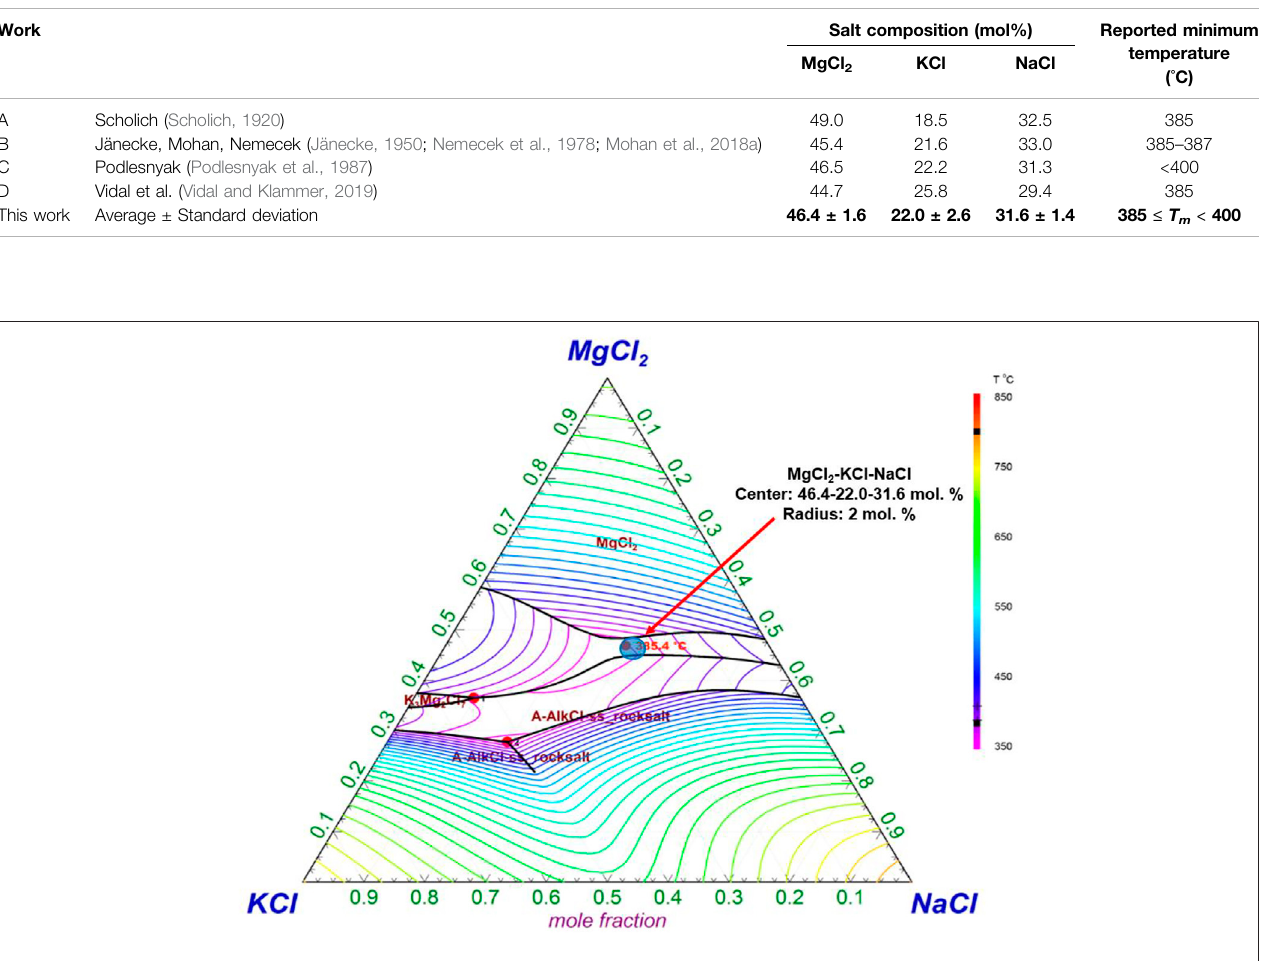
FIGURE 4 | Ternary phase diagram of the MgCl 2 – KCl – NaCl obtained from FactSage 7.2 thermodynamic database in this work (lines: isothermal liquidus projections). Thebluecircle,whichrepresents theaverageand standarddeviationoftheminimummelting temperature salt compositionfrom Table2 ,isalsopresented for